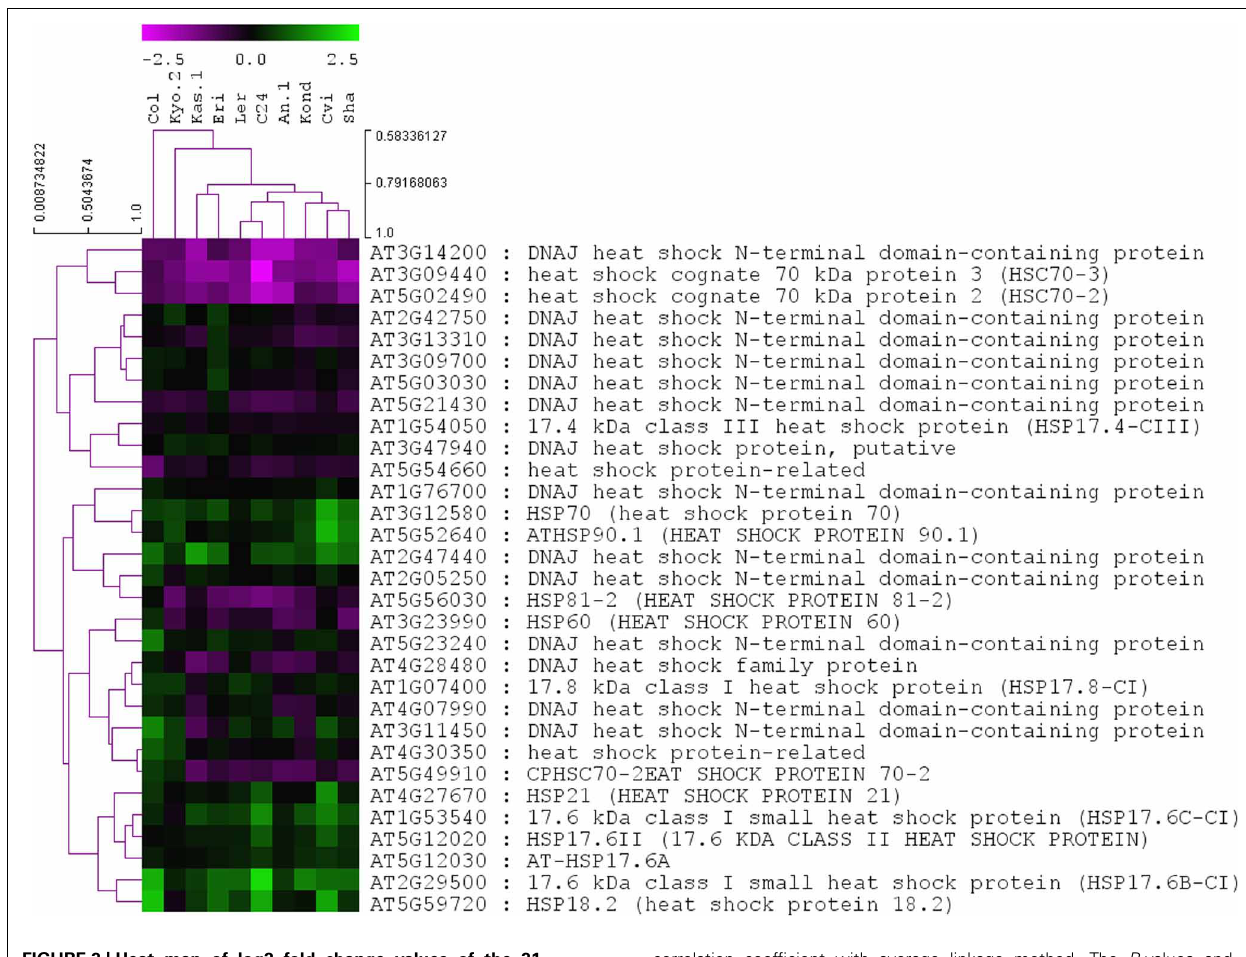
FIGURE 3 | Heat map of log2 fold change values of the 31 significantly regulated ( p ≤ 0 . 01) HSP genes in 10 A. thaliana ecotypes. Genes and ecotypes were clustered using Pearson’s